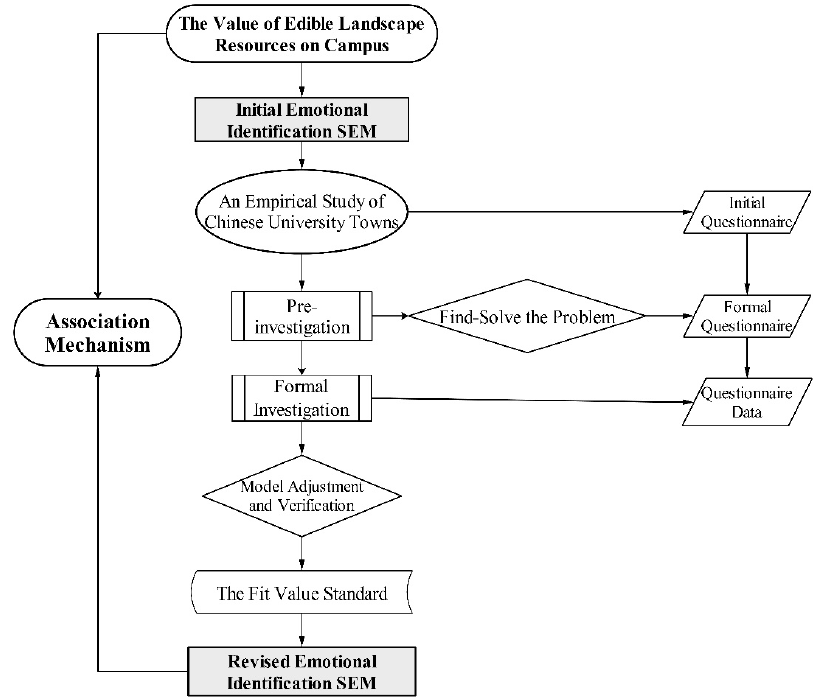
Figure 1. SEM flow